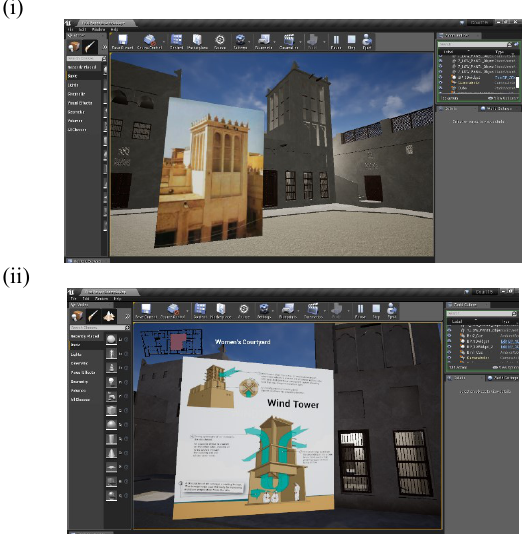
Figure 13. The VR project and its implemented functions. The historic photo of the wind tower in order to observe the architectural changes of the building (i) and 3D widgets that open and close reveal description and drawings about the architectural and bioclimatic devices